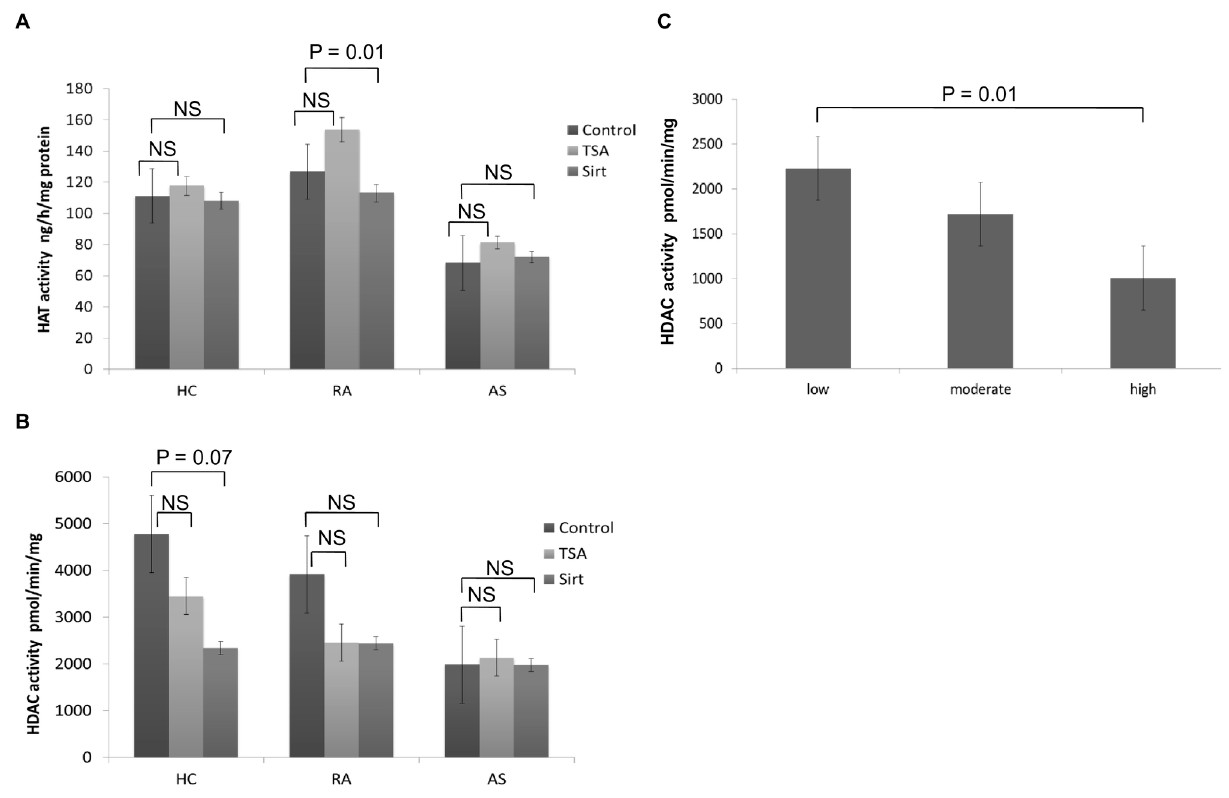
Figure 1. HAT and HDAC activity in HC, RA and AS subjects. Histone acetyltransferase activity ( A ) and histone deacetylase activity ( B ) in PBMC nuclear extracts from healthy controls (N = 38) and patients with rheumatoid arthritis (N = 52) or ankylosing spondylitis (n = 21). Enzymatic activity was measured without (control) and with histone deacetylase inhibitors, trichostatin A (TSA) or sirtinol (Sirt). ( C ) HDAC activity in PBMC nuclear extracts from subpopulations of RA patients based on DAS28 score